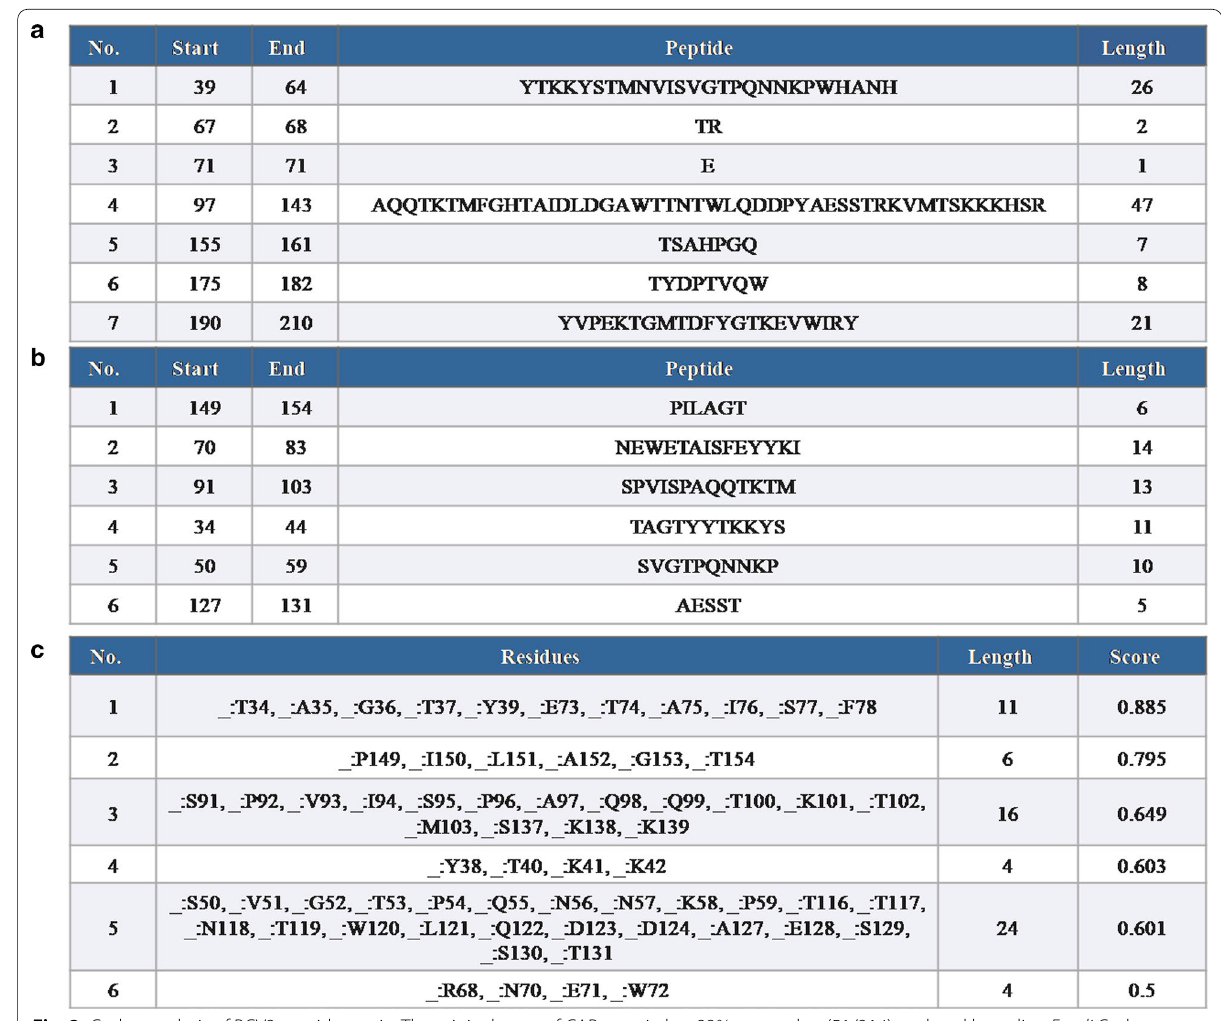
Fig. 2 Codon analysis of PCV3 capsid protein. The original gene of CAP protein has 23% rare codon (51/214) analyzed by online E. coli Codon Usage Analysis 2.0, which were replaced in the codon-optimized sequence without changing the amino acid sequence. The codon in the shadow represents a rare codon. The underlined sequence was removed in the truncated CAP protein (ΔCAP). The concentrated arginines area is in the